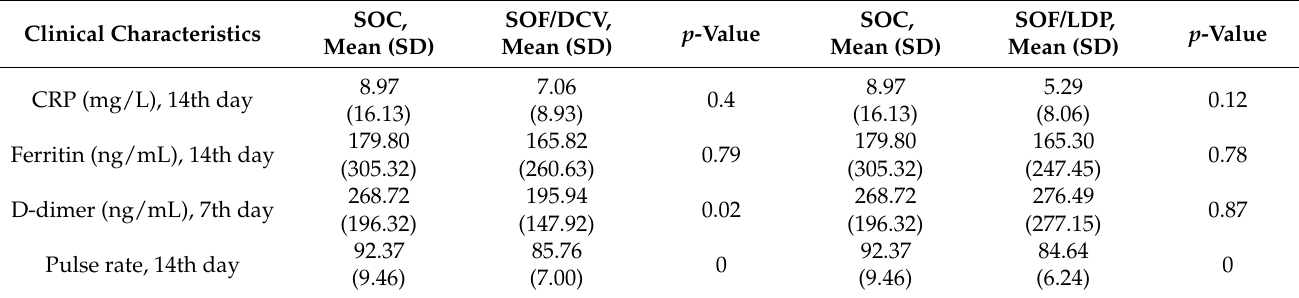
Table 3. Clinical outcomes of the patients after